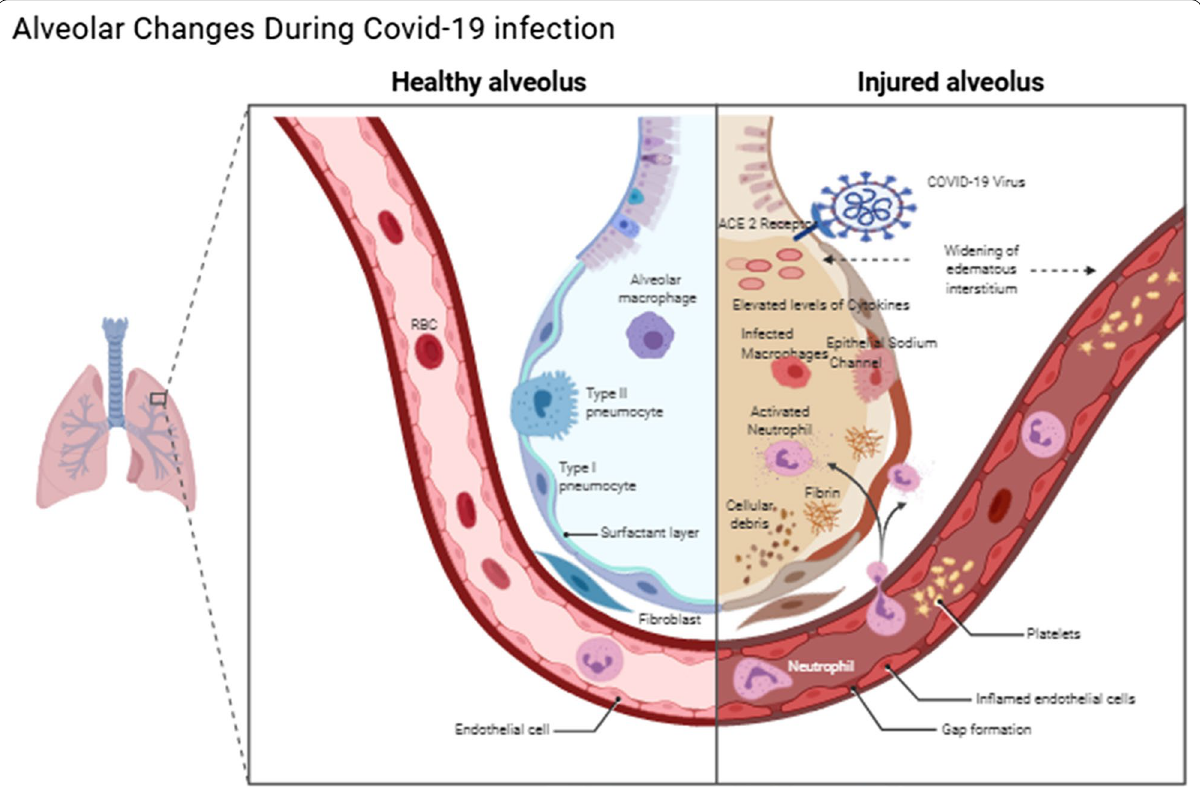
Fig. 1 Alveolar changes during covid-19